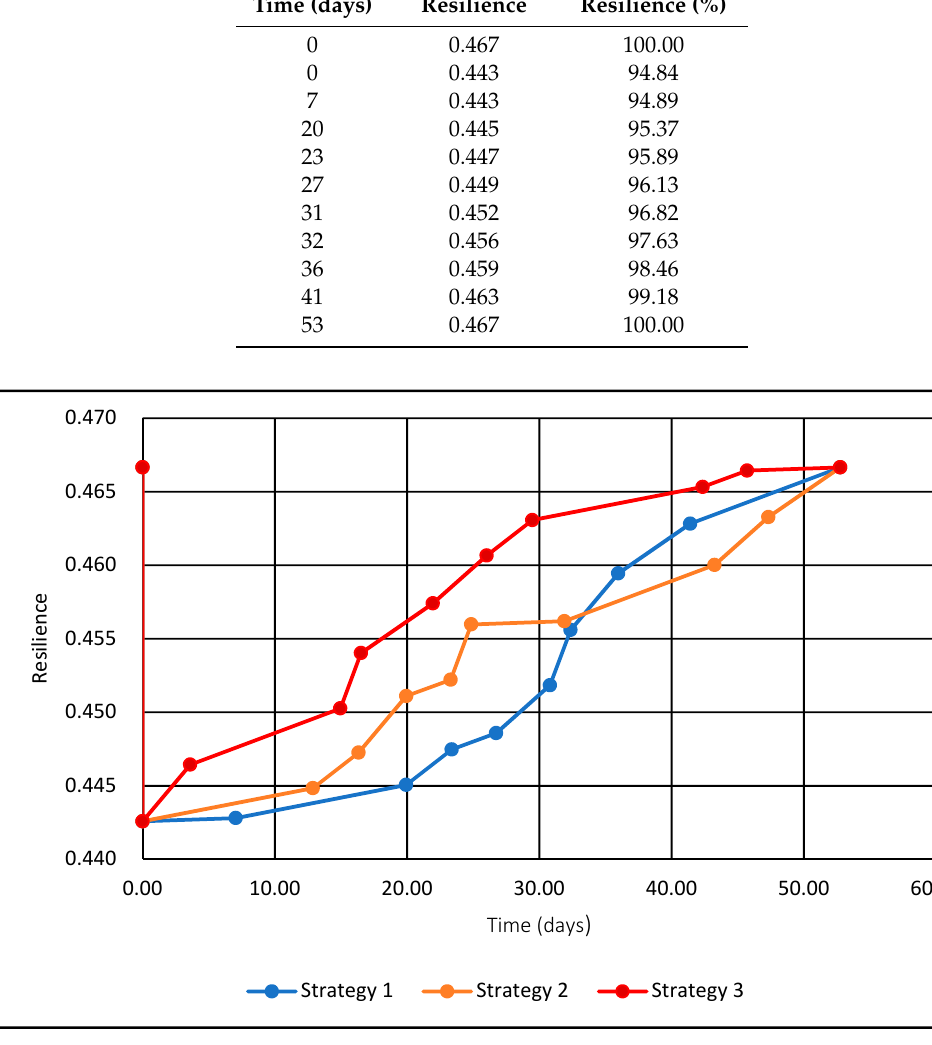
Figure 13. Comparison of three resilience restoring strategies based on the proposed metric.